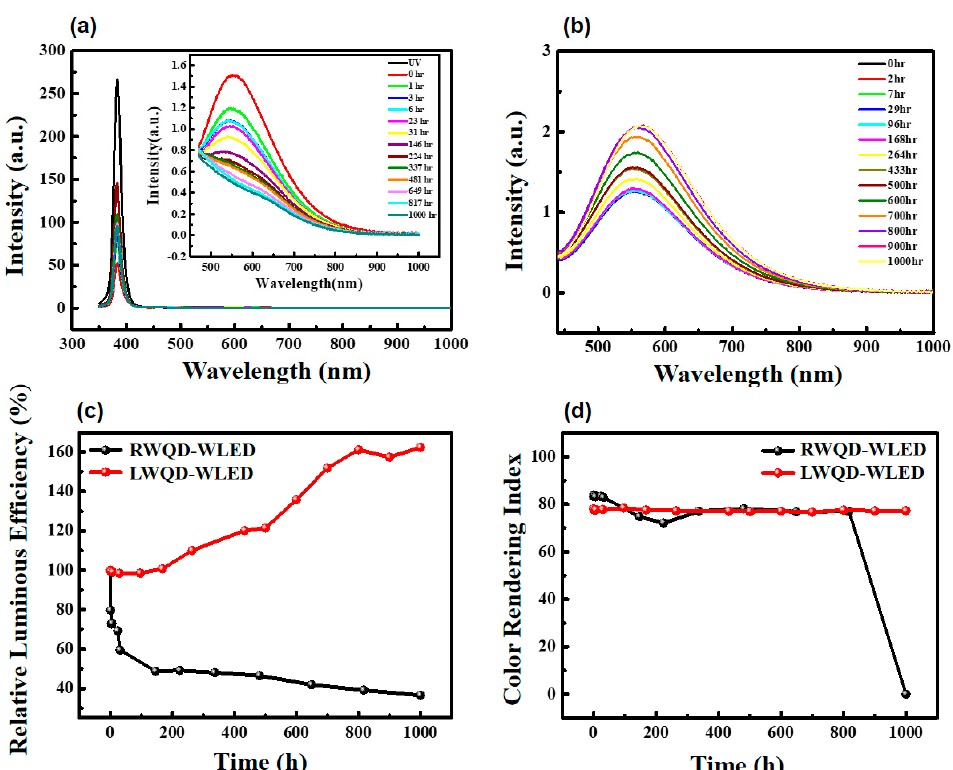
Figure 6. ( a ) The relative emission spectrum of the RWQD-WLED under various operation time, ( b ) The relative emission spectrum of the LWQD-WLED with various operation time. The lifetime character of ( c ) changing about relative luminous efficiency and ( d ) CRI between RWQD- and LWQD-WLED from 0 h to 1000 h. The inset in Figure 6. ( a ) is the QD part of the composition of the RWQD-WLED emission spectrum.